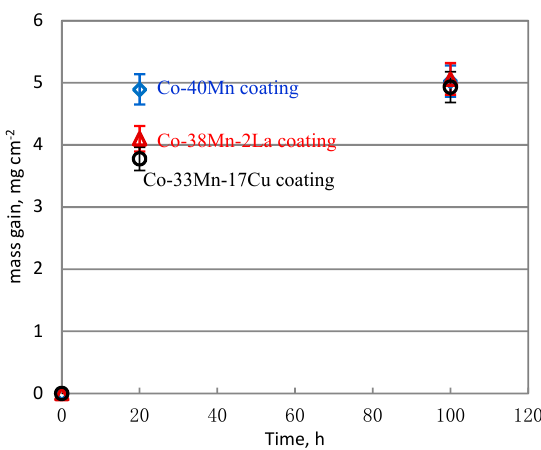
Figure 3. Mass gain of oxidized coatings at 750 °C in air.